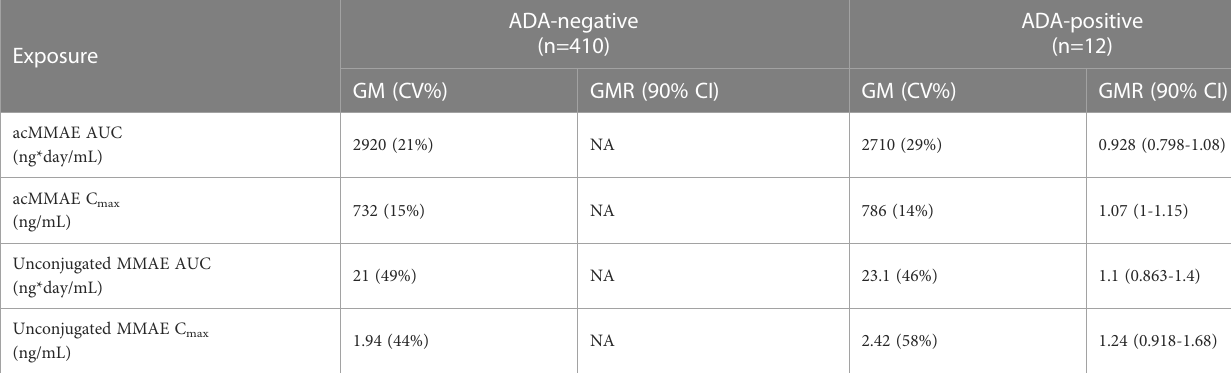
TABLE 6 Comparison of covariate-corrected exposures in ADA-negative patients and ADA-positive.